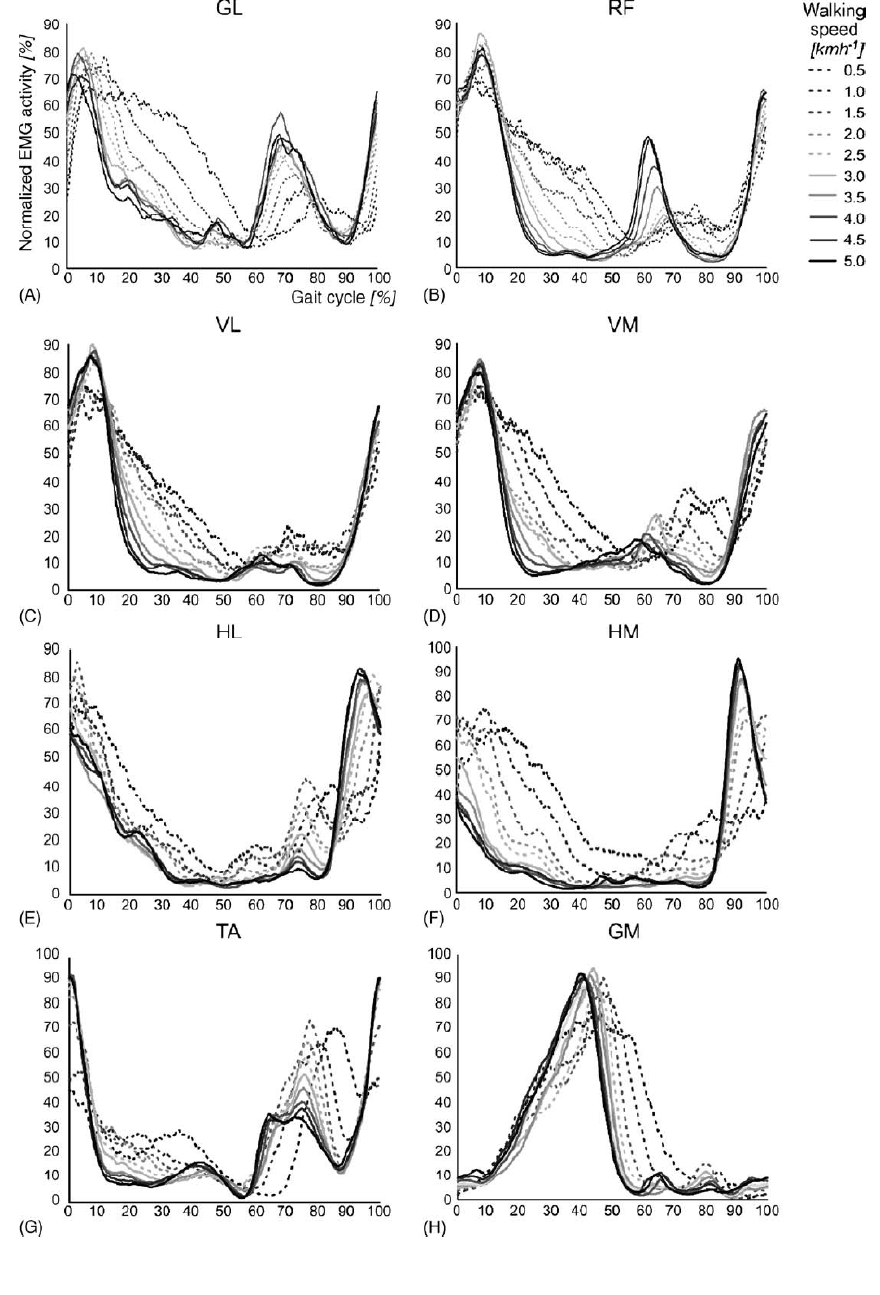
Figure 3. Influence of walking speed on electromyographic (EMG) activity patterns. EMG activity patterns during different walking speeds of the ( A ) gluteus maximus (GL); ( B ) rectus femoris (RF); ( C ) vastus lateralis (VL); ( D ) vastus medialis (VM); ( E ) lateral hamstrings (HL); ( F ) medial hamstrings (HM); ( G ) tibialis anterior (TA); and ( H ) gastrocnemius medialis (GM) muscles. EMG signals were normalized for each subject and each condition by setting the difference between the lowest and highest EMG amplitude at 100% and normalizing the curve according to this value (this figure is reproduced with permission from [17]; Copyright IOS Press,